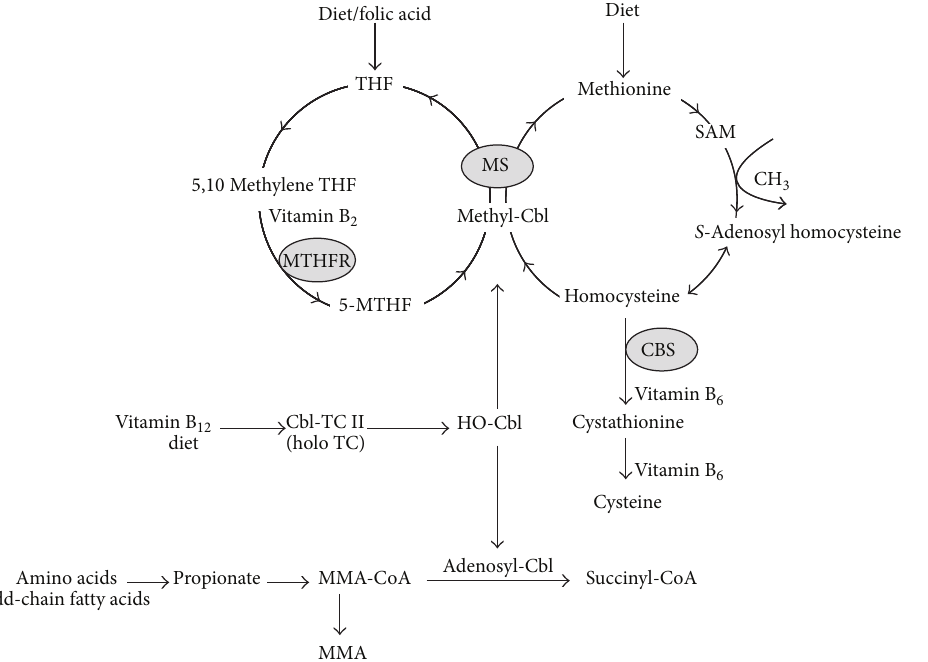
Figure 1: Homocysteine, folate, and vitamin B 12 metabolism. THF (tetrahydrofolate), 5-MTHF (5-methyltetrahydrofolate), MTHFR (methylene tetrahydrofolate reductase), MS (methionine synthase), CBS (cystathionine beta-synthase), SAM ( S -adenosyl methionine), Cbl (cobalamin), TC II (transcobalamin), holo TC (holotrascobalamin), OH-Cbl (hydroxocobalamin), MMA-CoA (methylmalonyl-CoA), and MMA (methylmalonic